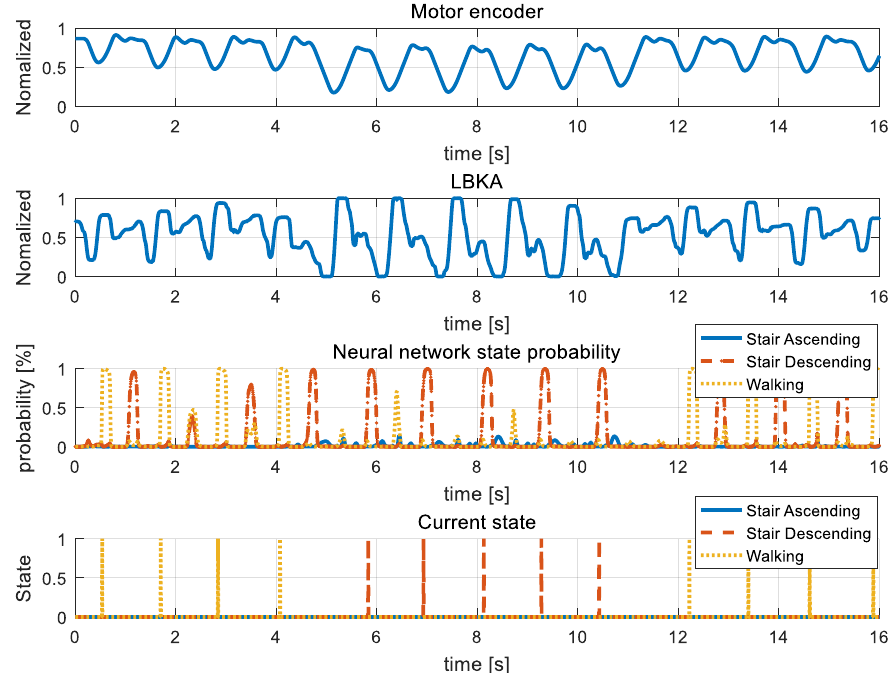
Figure 18. Mixed stair descending experiment with fast period.